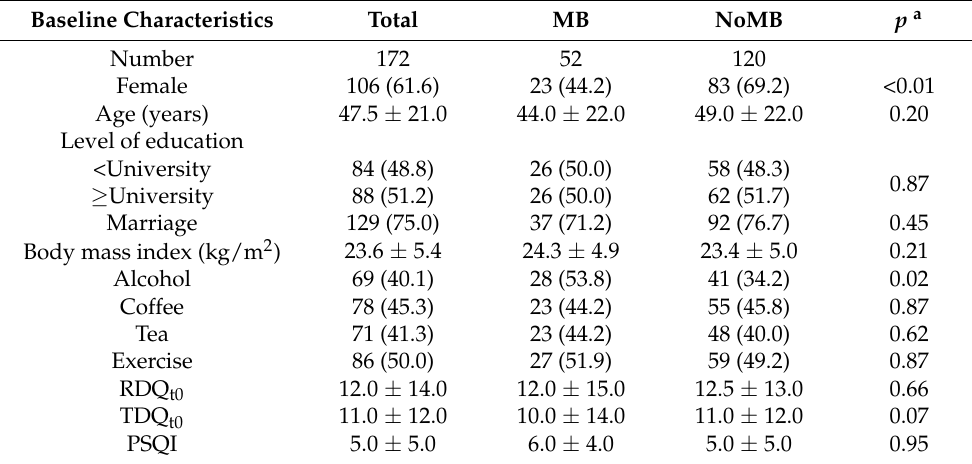
Table 1. Comparison between the characteristics of the MB and NoMB groups. Baseline Characteristics Total MB NoMB